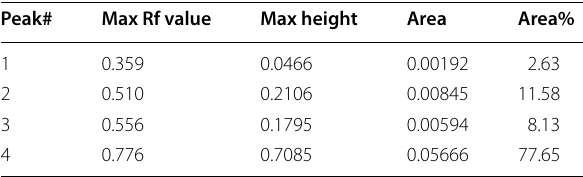
Table 4 HPTLC fingerprinting of the ethanolic extract of K. galanga